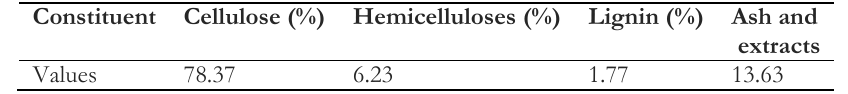
Table 3. Chemical composition of Bamboo fibre.